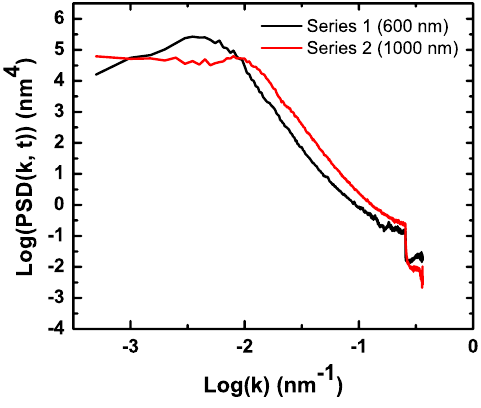
FIG. 7. PSD curves for the thickest Nb samples from each series.